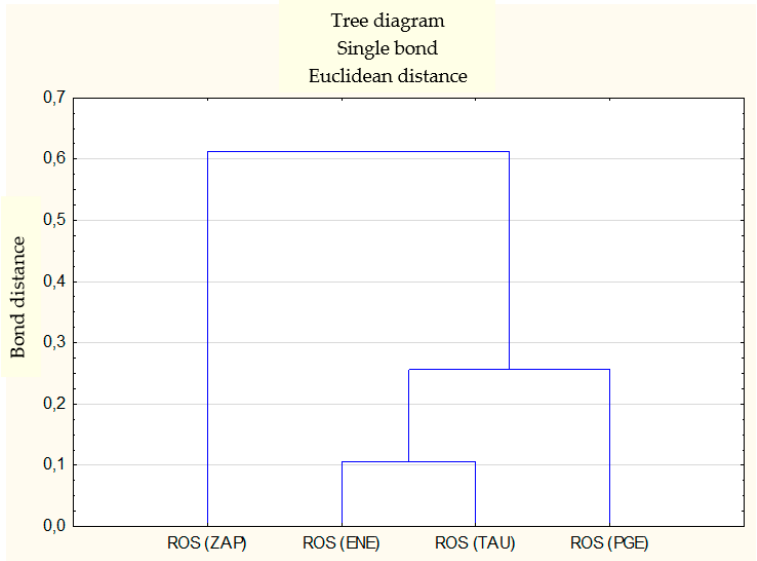
Figure 8. ROS ratios for the analyzed companies in 2009–2019 (%). Source: Own elaboration.